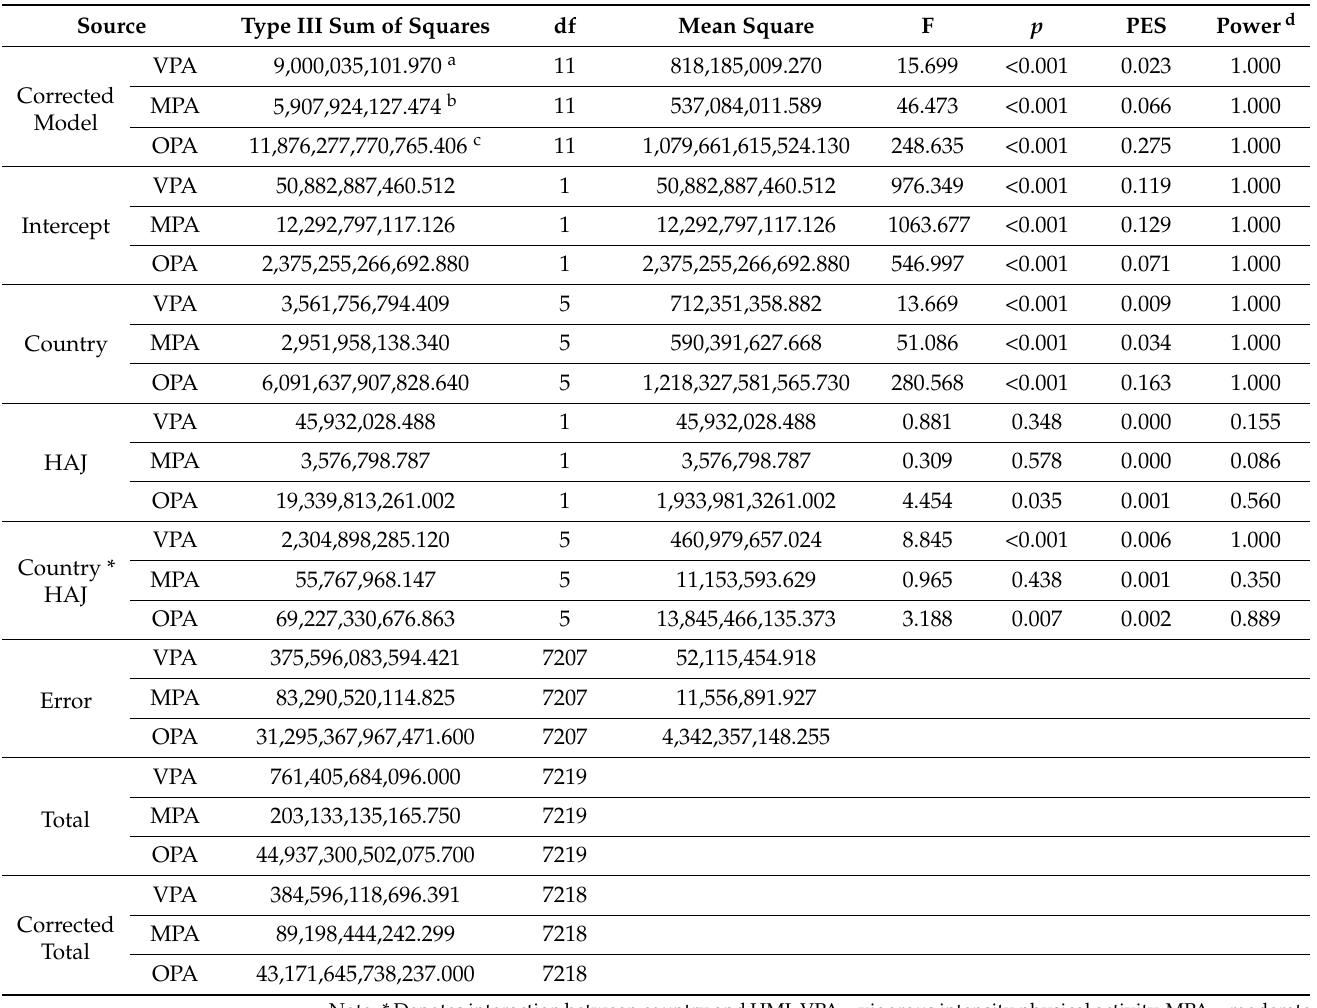
Table A5. Tests of between-subjects